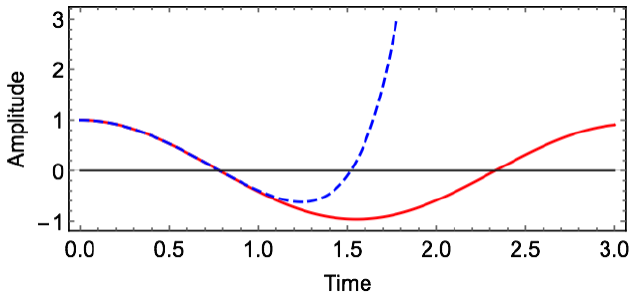
Figure 1. The red curve is the numerical solution and the dashed blue curve is the solution by the DTM.